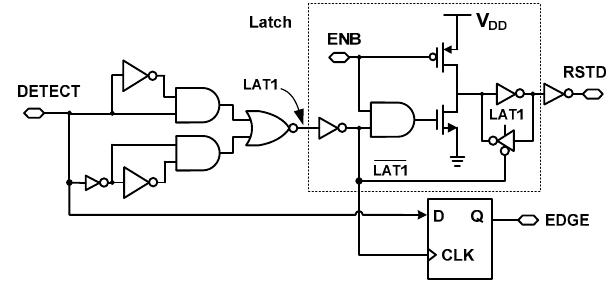
Figure 12. Schematic of the edge-type detector.